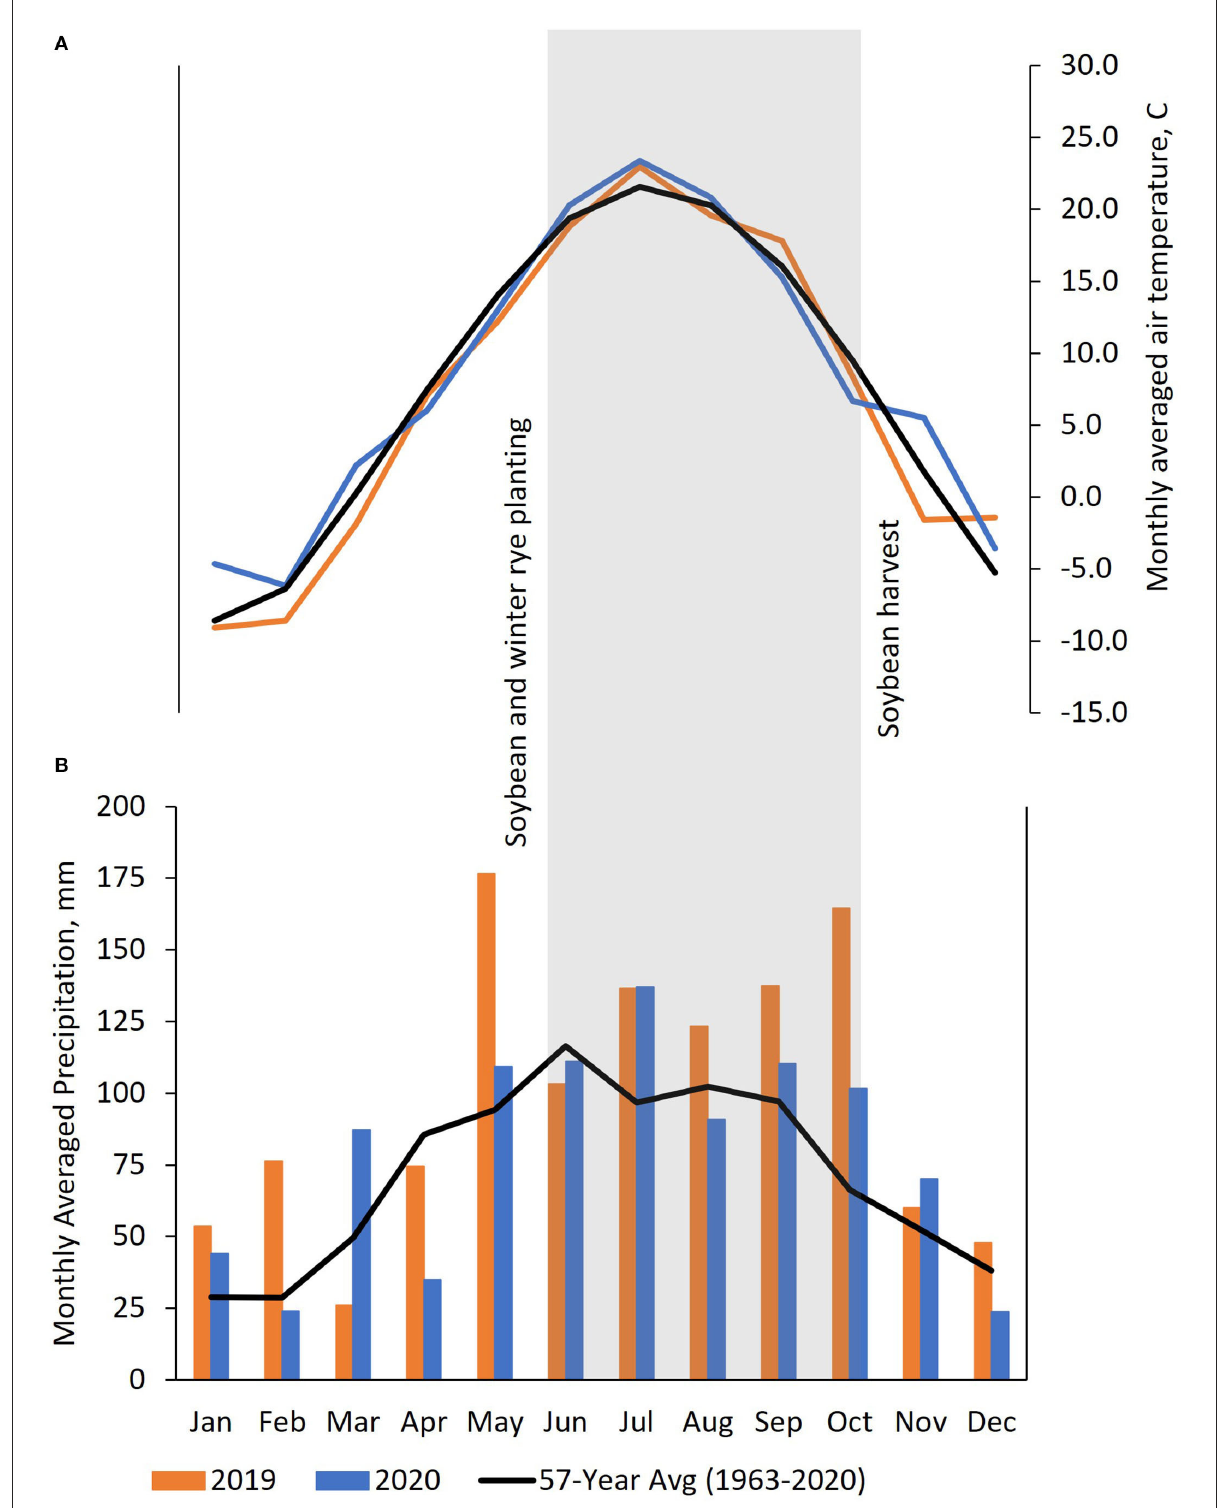
FIGURE1 (A) Monthly averaged air temperatures ( ◦ C) and (B) precipitation (mm) plotted against 57-year averages (1963–2020) at the Arlington Agricultural Research Station, Arlington, WI, 2019–2020. Area shaded in gray signifies the active growing season of soybean during the 2 study